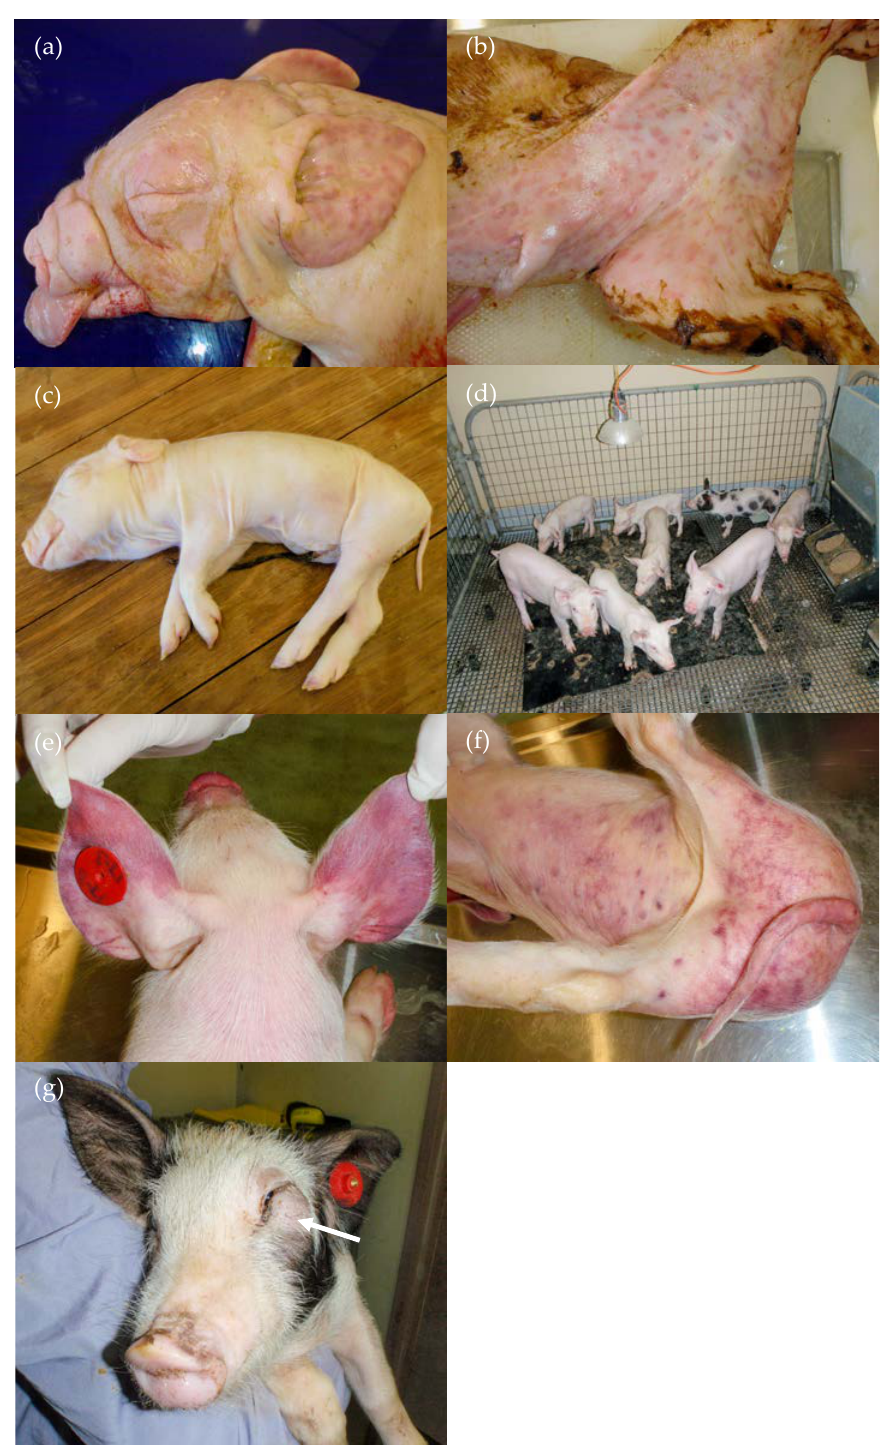
Figure 1. Clinical signs observed in D35 pigs: ( a ) purpura, subcutaneous oedema and absence of facial whiskers (12-09, stillborn); ( b ) purpura (17-11, stillborn); ( c ) subcutaneous oedema—most evident ventrally (12-10, 1 day old); ( d ) remaining pigs at 7 weeks of age with stunting of 6 smaller pigs compared with the 2 larger, non-PI pigs; ( e ) 26-day-old pig with purplish discolouration of the ears and snout (17-03); ( f ) same pig as (e) with purplish discolouration ventrally and on hind-quarters; and ( g ) 16-07 (62 days old) with mass under left eye, resulting in closure of the eyelids (arrow).